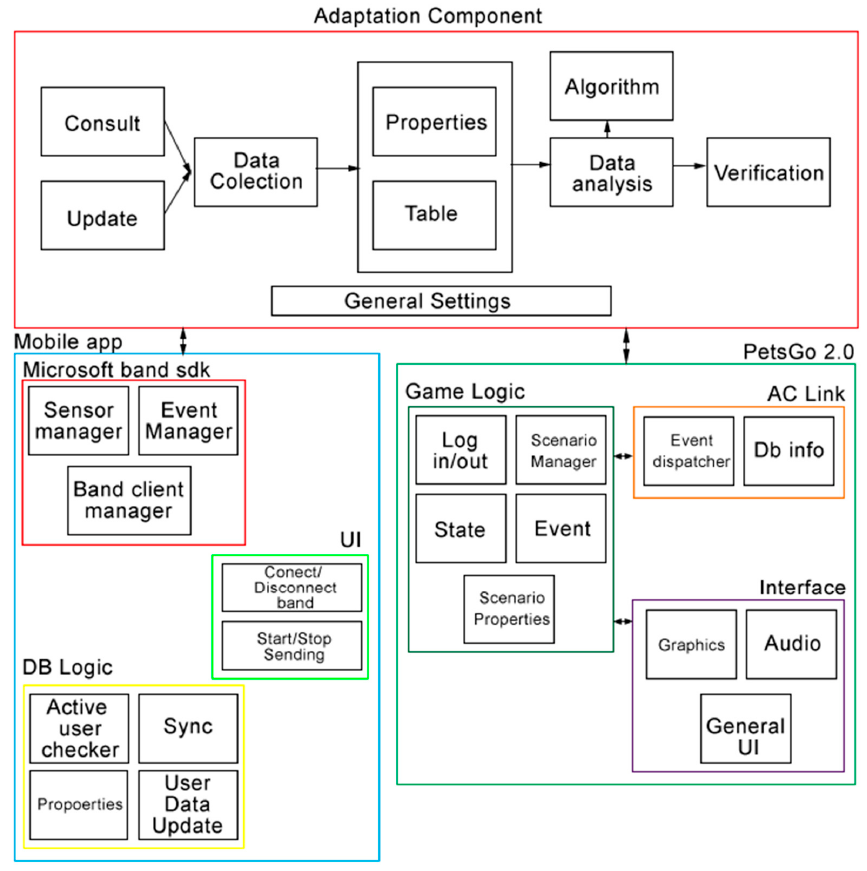
Figure 3. Integrated system architecture: AC, mobile application, and PetsGo 2.0.